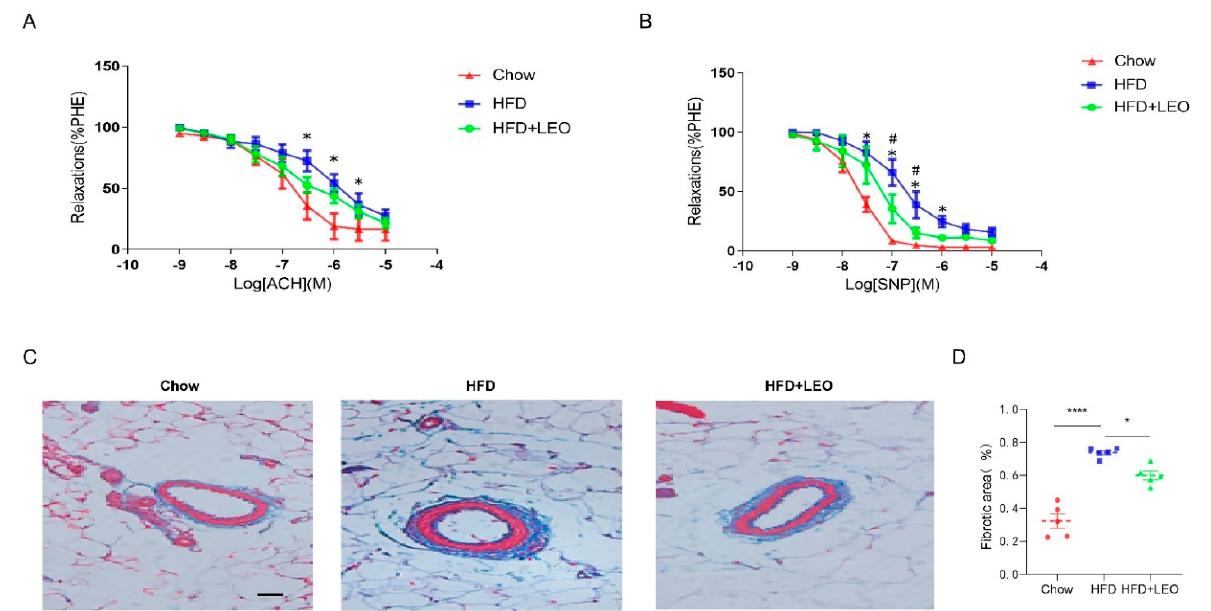
Figure 4. LEO improves vascular function and remodeling. ( A ) Endothelium-dependent relaxation (EDR) of mesenteric artery ring from groups of mice in response to ACH. * p < 0.05 between chow group and HFD group. ( B ) SNP-induced endothelium-independent relaxation of mesenteric artery ring from groups of mice. * p < 0.05 between chow group and HFD group. # p < 0.05 between HFD group and HFD + LEO group. ( C ) The structure of collagen fiber was observed by Masson’s trichrome staining. Collagen fibers are in blue and the smooth muscle fibers are in red; n = 5 mice per group. ( D ) The quantitative analysis of the percentages of collagen content. Data are shown as means ± S.E.M. * p < 0.05 and **** p < 0.0001 between groups.